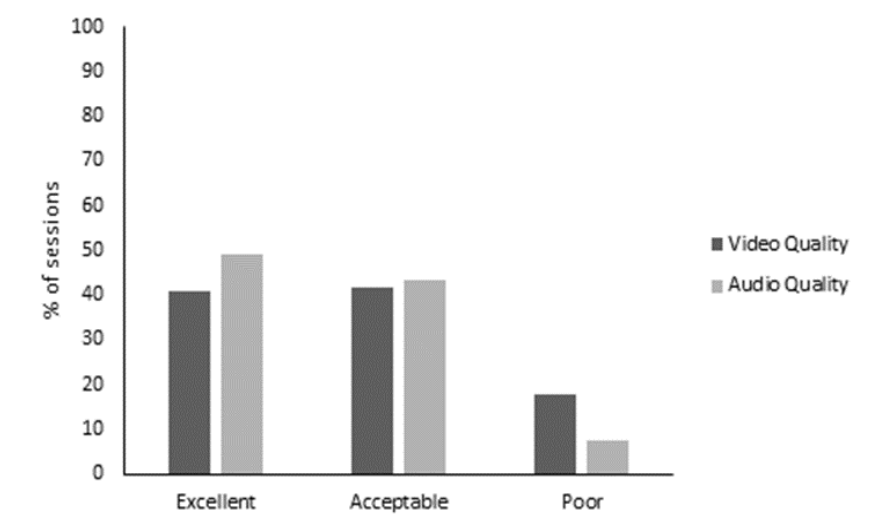
Figure 1. System and quality and usability (participant feedback).